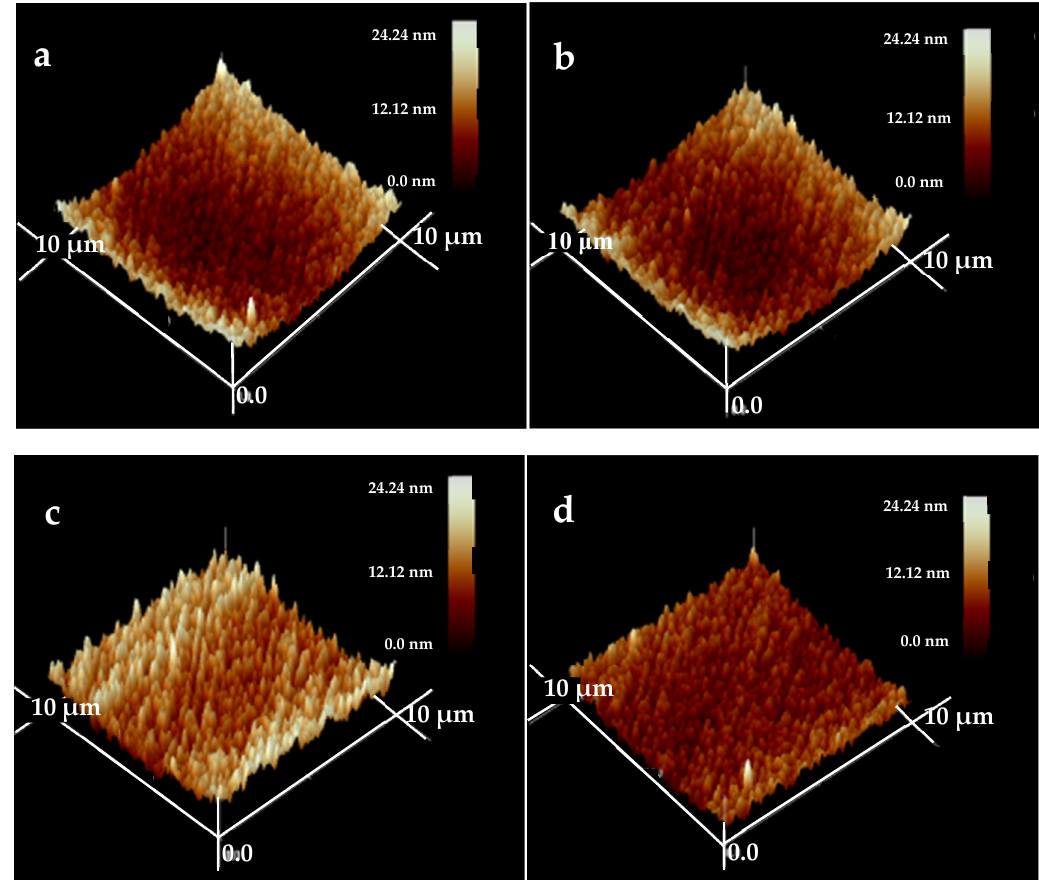
Figure 6. AFM topography images of HfC coatings deposited at different bias voltages: ( a ) 0 V, ( b ) − 100 V, ( c ) − 150 V, and ( d ) − 200 V.